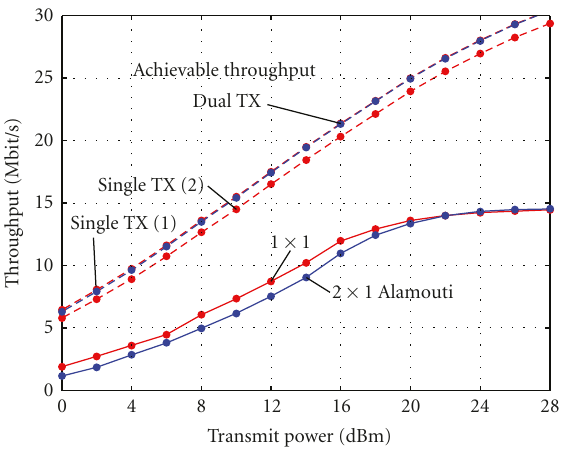
Figure 10: Scenario 3, measured (solid) and achievable (dashed) data throughput in the LOS outdoor-to-indoor scenario using one receive antenna. The largest transmit power corresponds to a receive SNR of about 32dB.